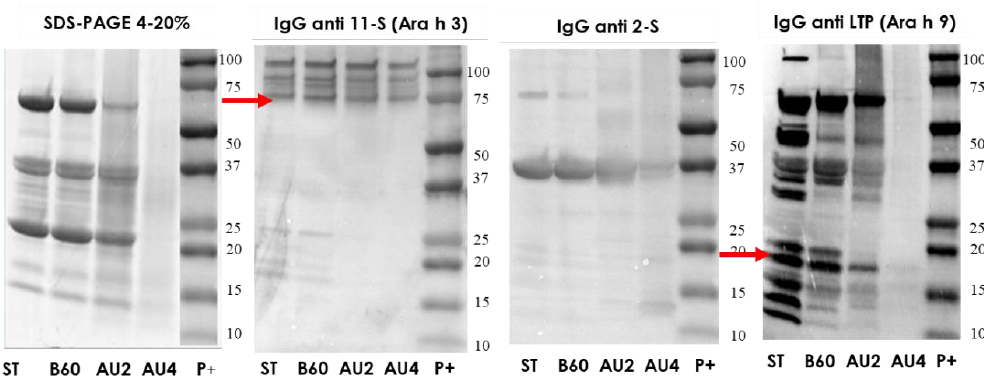
Figure 3. SDS-PAGE and IgG anti-11S, anti-2S and anti-LTP immunoblots analysis of control (ST), boiled 60 min (B60) and autoclaved at 121°C for 30 min (AU2) and 138 °C for 30 min (AU4) peanut samples. Molecular weight marker was Precision Plus (P + ).